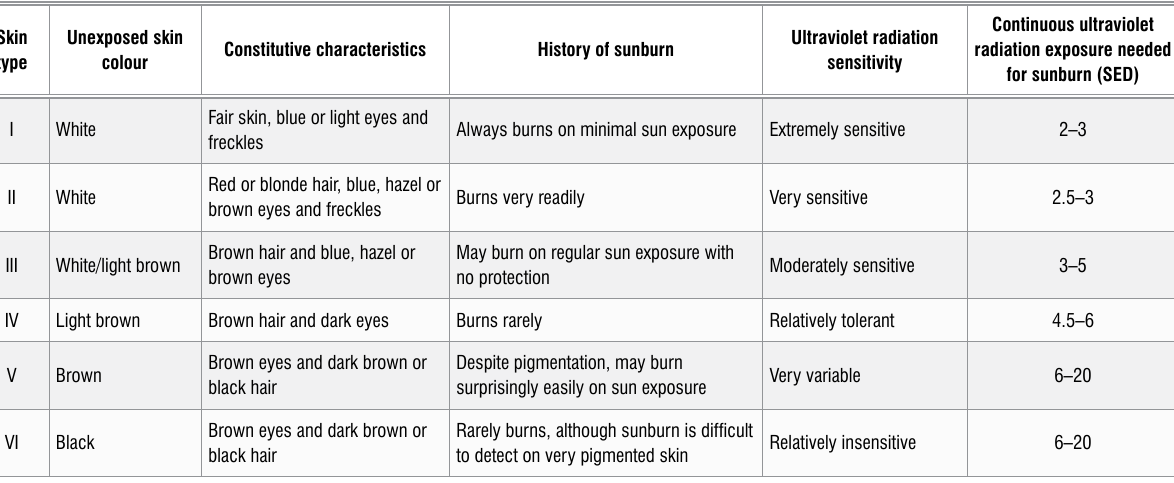
The Fitzpatrick skin phototype classification